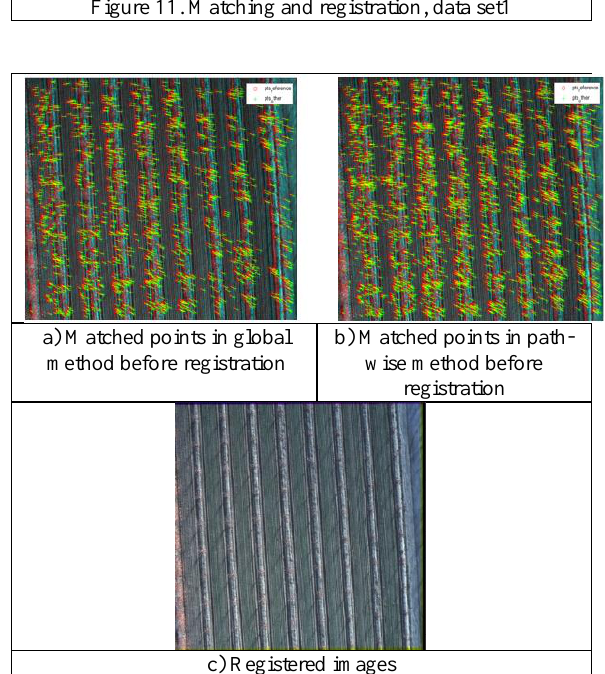
Figure 12. Matching and registration, data